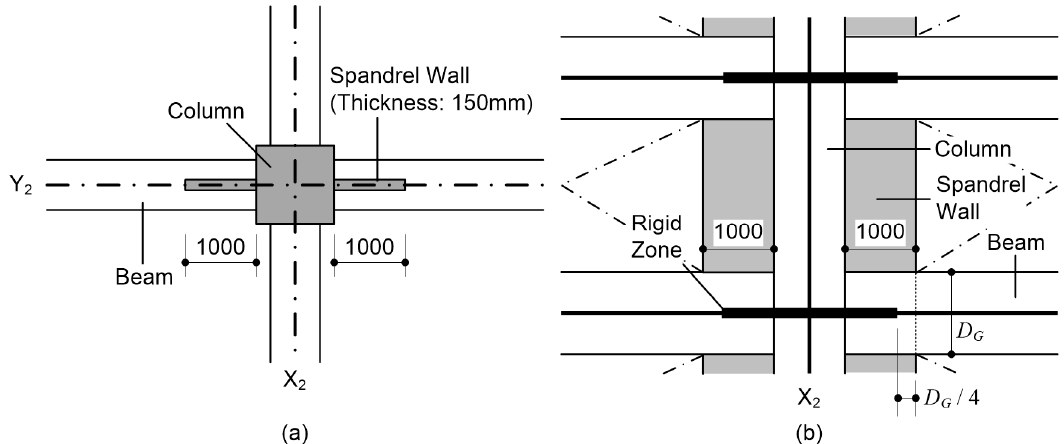
Figure 4. Details of column X 2 Y 2 with spandrel wall: ( a ) plan view; ( b ) elevation view.